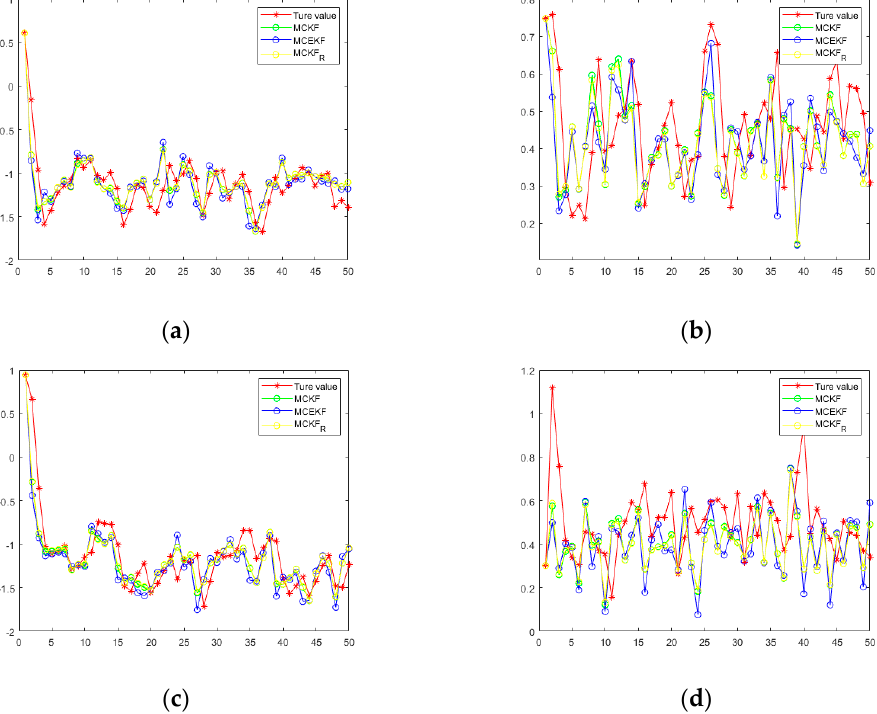
Figure 3. ( a , b ) Set parameters: σ = 5, ε = 10 − 6 in case 1; ( c , d ) set parameters: σ = 10, ε = 10 − 6 in case